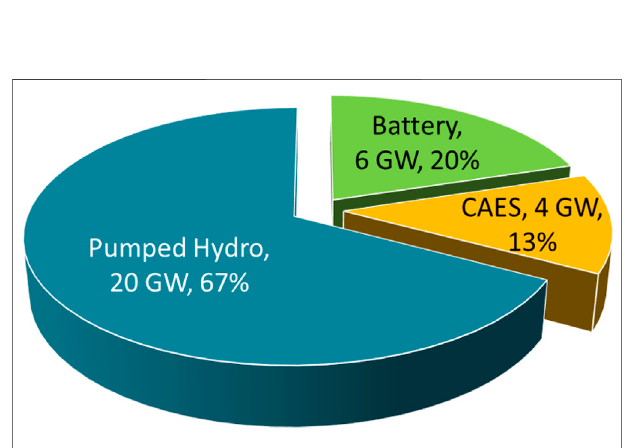
FIGURE 3 | Installed energy storage capacity of WI in the 2050 baseline